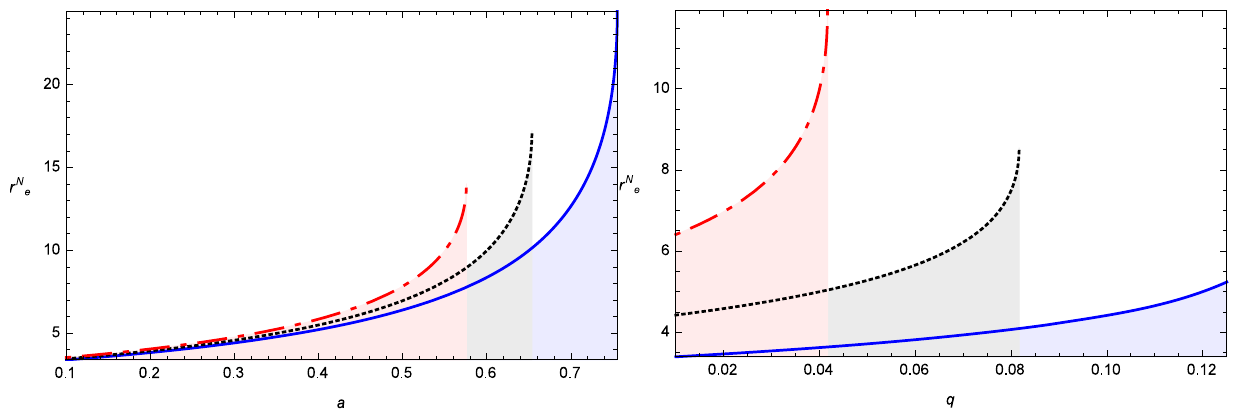
Fig. 10 Shows the graphic analysis of r N (negative). The left panel represents q = 0 . 01 (blue), q = 0 . 02 (black), and q = 0 . 03 (red). The right b panel represents a = 0 . 1 (blue), a = 0 . 3 (black), and a = 0 . 5